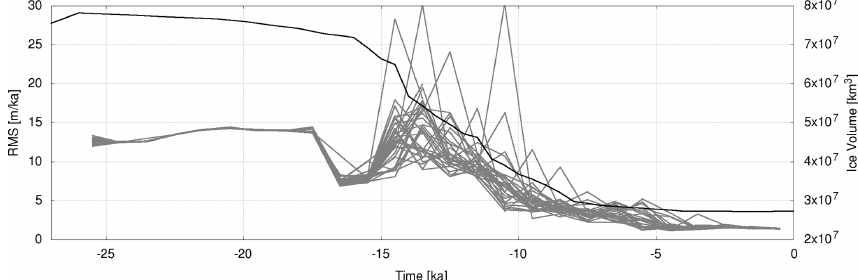
Figure 9. Measures of misfit variation for the ensemble of scenario three in set-up 1 (Case E) in grey. Shown are the RMS values of the difference between the observations and the model predictions. The black line shows the total ice volume according to the external ice